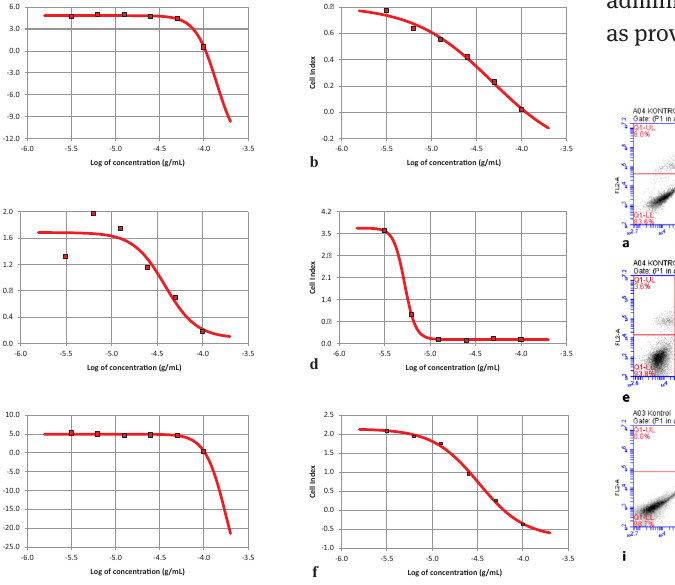
. Apoptosis was increased (b) 2.21 A